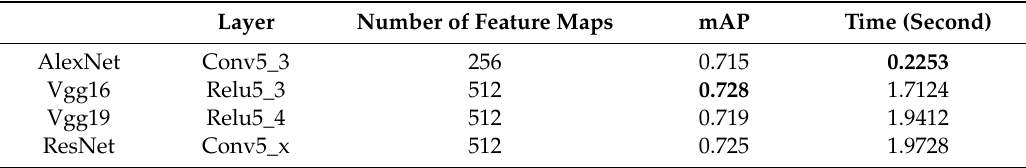
Table 1. Performances of our method when using di ff erent pre-trained convolutional neural networks (CNNs) on